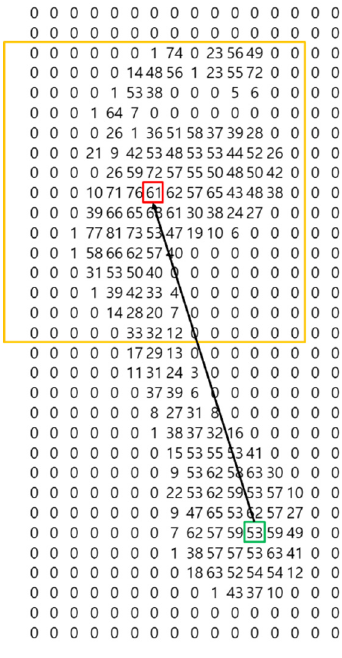
Figure 7. Comparison of least square calculations referenced to x - or y -axis. Figure 7 shows that the same data can have different linear functions associated with it, depending on which axis is taken as the reference line. In this study, the method of deriving the principal components (PCs) using principal component analysis (PCA) [28,29] is applied. PCs are saved in PCA in total least square (TLS) or orthogonal least square (OLS) format, in order to find an N -dimensional vector with minimal mean square distance between the original dataset and this N - dimensional vector as projected onto the original dataset. This is equivalent to finding the N - dimensional vector with the largest variance out of the data projected onto it [30]. For example, Figure 8 shows three one-dimensional vectors—two principal component vectors and the result as projected on each vector—in a two-dimensional data scatter plot. The projected